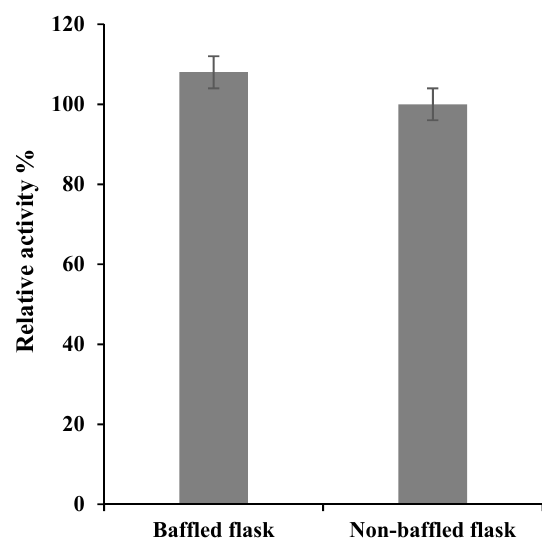
Figure 2. The effect of baffled versus non-baffled flask on the production of S. griseus recombinant β -glucosidase. Recombinant β -glucosidase was expressed in basal medium supplemented with 0.5% (w/v) fructose, 1% (w/v) yeast extract and tryptone at 37 °C for 6 hours, following 1 mM IPTG induction. Enzyme activity was used as a proxy to enzyme production. The data represented are the mean of three independent experiments, with the standard deviations noted as error bars. Both baffled and non-baffled flasks show no significant difference between them ( p -value ≥ 0.235) based on two-tailed t- test.